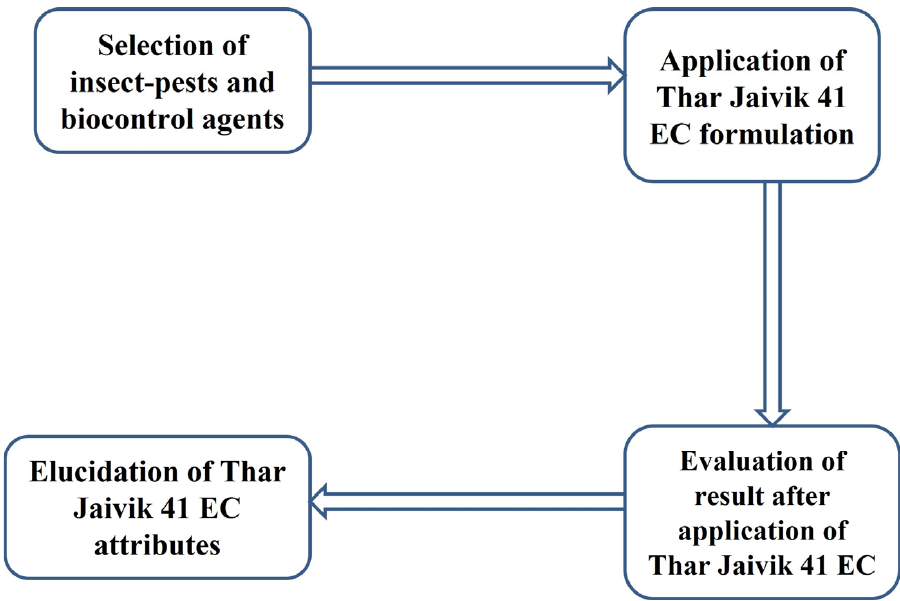
Figure 2. Diagrammatic depiction of the effect of biopesticide formulation “Thar Jaivik 41 EC” against insect pests and biocontrol agent.